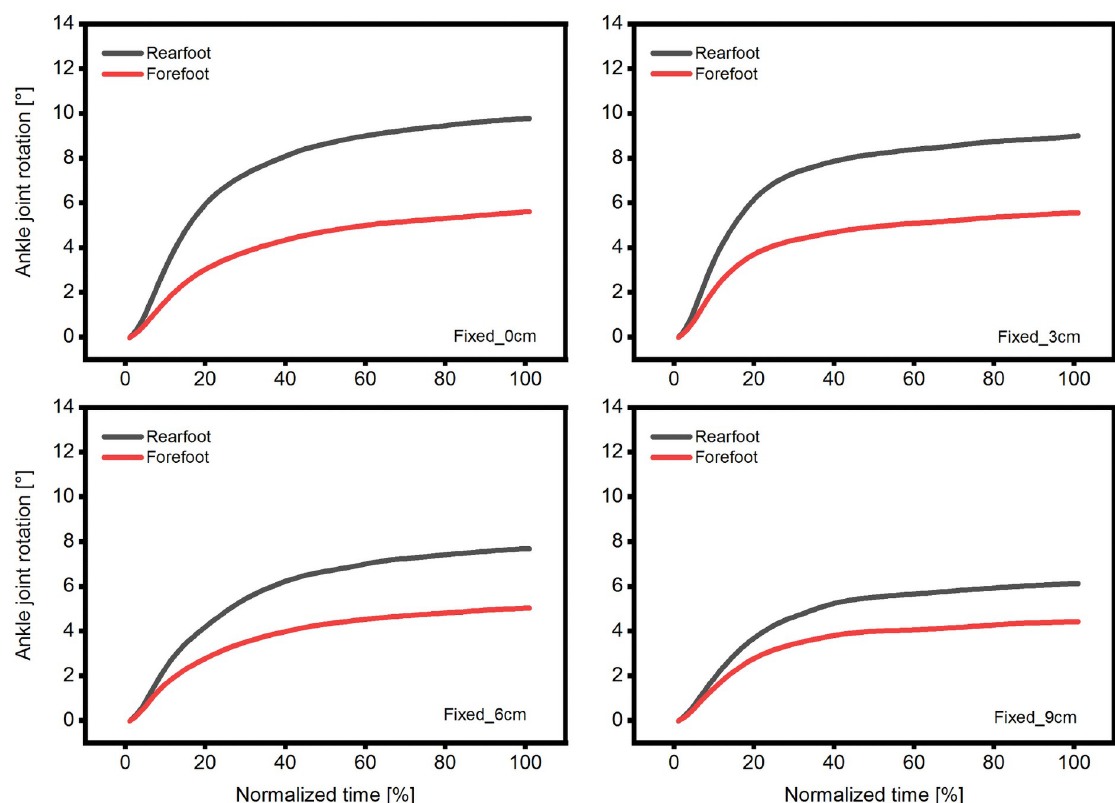
Fig 6. Time normalized ankle joint rotation at four different positions in fixed condition. Time normalized average ankle joint angle measured in rearfoot and forefoot measuring sites at four different positions (0–9 cm) and in fixed condition. For clarity, the standard deviation is not presented (n =